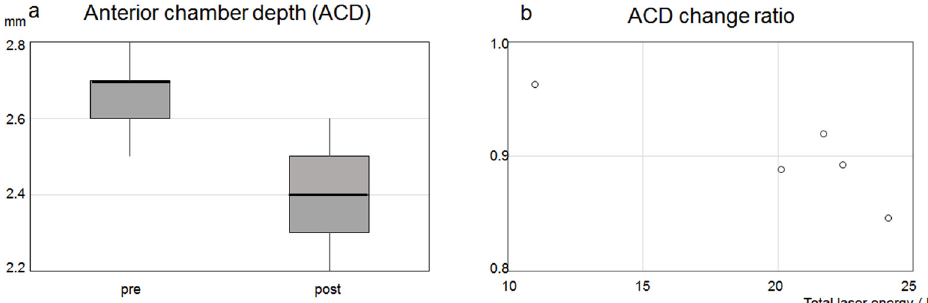
Figure 2. Although laser irradiation caused anterior chamber depth to become significantly shallower, there was no correlation with the amount of laser irradiation energy. ( a ) Box-plot diagram showing mean values of anterior chamber depth in the eye before and after laser irradiation. Boxes, interquartile range (difference between upper 75% and lower 25% quartiles); thick black lines, median; whiskers, highest and lowest values that were not outliers or extreme values. A significant difference was observed in ACD before and after laser irradiation ( p = 0.042 < 0.05)). ( b ) There was no correlation between laser irradiation energy dose and ACD change ratio ( p = 0.054 > 0.05).